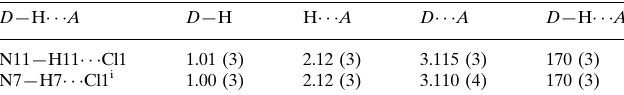
Hydrogen-bond geometry (A˚ , (cid:4)